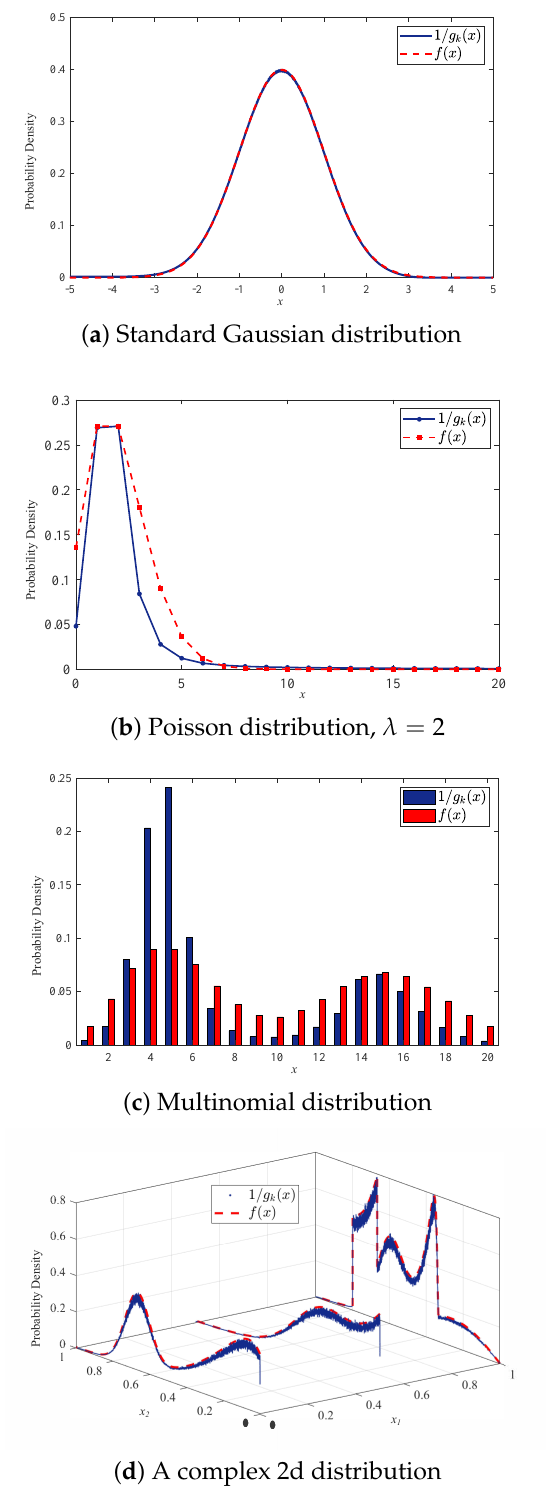
Figure 1. Similarity between inverse k NN distance 1/ g k ( x ) and likelihood f ( x ) for k =